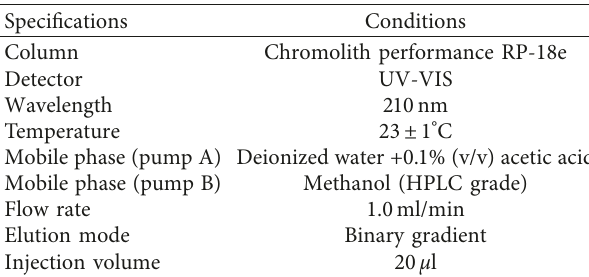
Table 3: Specifications and conditions of saponin detection in C. papaya